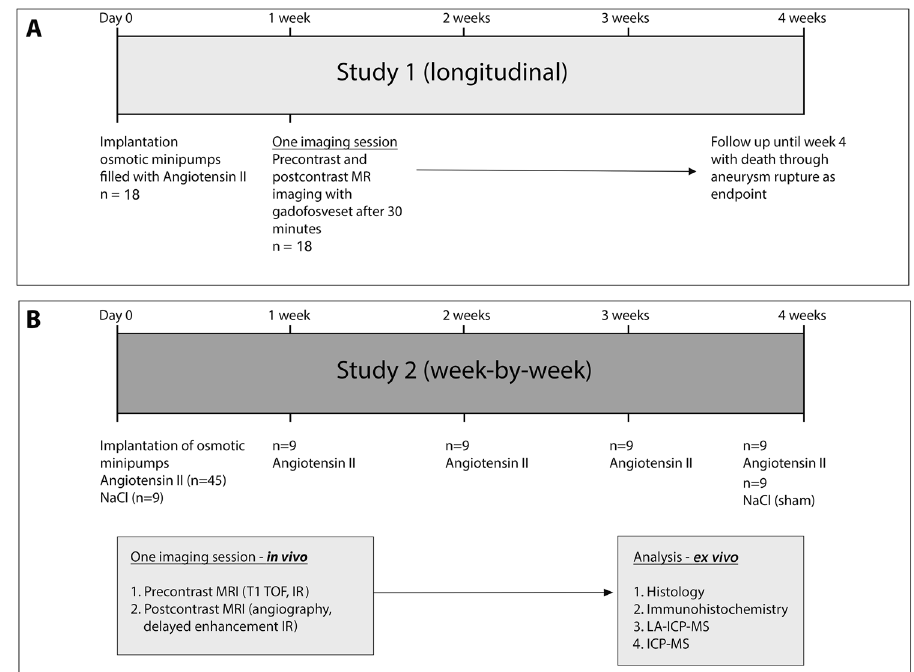
Figure 1. Experimental setup. ( A ) For study 1 (longitudinal), a single MRI session was performed after one week (n = 18) with injection of a clinical dose of the albumin-binding probe gadofosveset. After imaging, animals were followed up for up to four weeks with death by aneurysm rupture as endpoint. The aim was to evaluate the potential of gadofosveset to predict aneurysm rupture. ( B ) In study 2 (week-by-week study), imaging after administration of gadofosveset (0.03 mmol/kg) was performed after 1, 2, 3, and 4 weeks (n = 9 per group) of angiotensin II infusion. Ex vivo analysis (histology, fluorescence immunohistochemistry, ICP-MS and LA-ICP-MS) was performed after the final scan of each week (n = 9 per week) to correlate in vivo with ex vivo results. As control, nine sham-treated ApoE − / − mice were implanted with osmotic minipumps primed with sodium